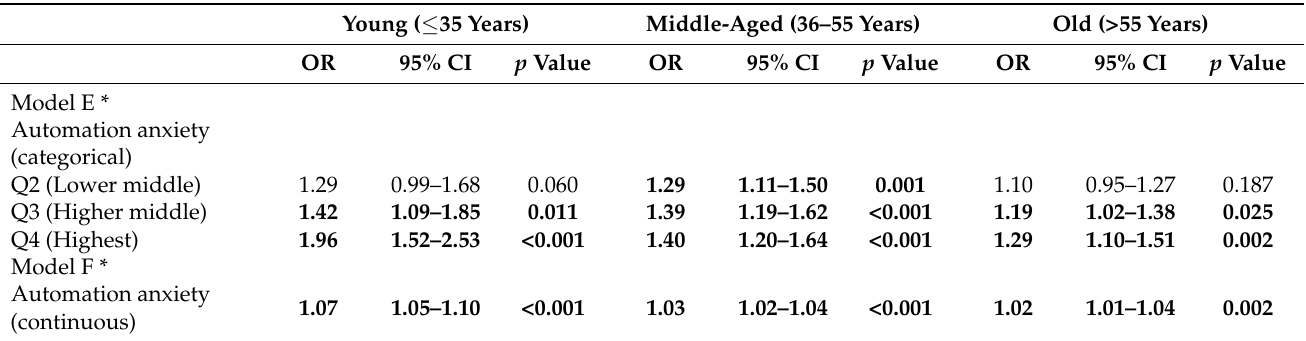
Table 4. Stratified analyses by each age subgroup in a fully-adjusted model. Bold indicates statistically significant values. [OR: odds ratio; CI: confidence interval].